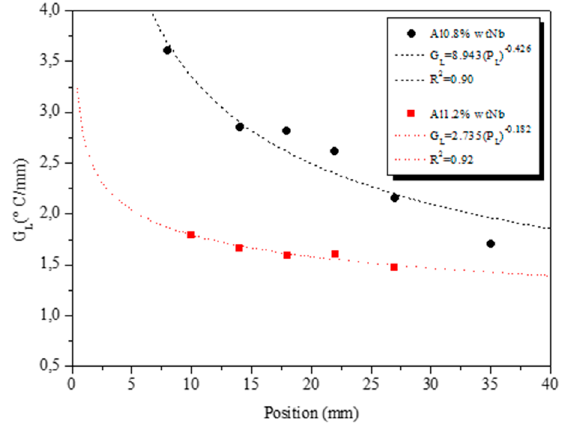
Figure 5. Thermal gradient as a function of position from the metal/mold interface.